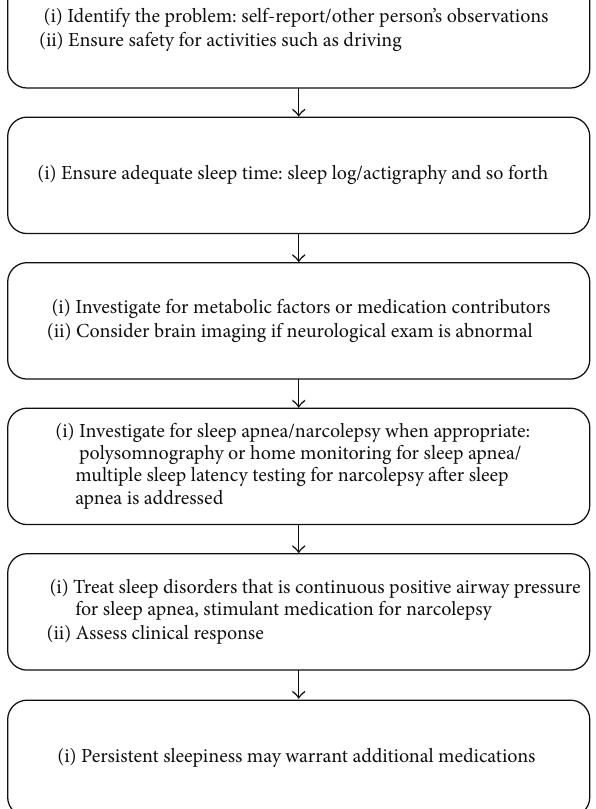
Figure 1: Clinical approach to excessive daytime